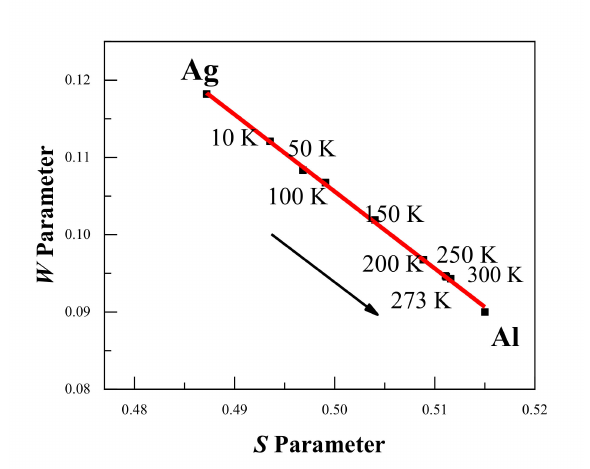
Figure 4. S-W plot for the Al-0.2 wt.%Ag alloys at different temperatures. The arrow shows the increase in the measurement temperature, and the movement of the S-W characteristic points from Ag towards Al. The red line is presented as a visual aid.